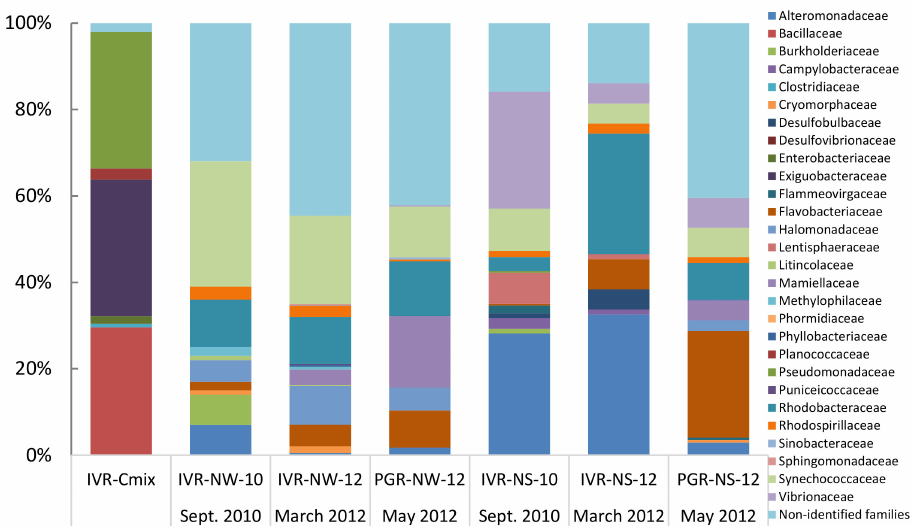
Figure 3. Relative composition (% total) of identified bacterial families represented by 16S rDNA sequences from cultures (IVR-CMix) and environmental samples collected at the Veracruz Reef System from different years (indicated by numbers), seasons and ecological compartments (N = Natural (non-cultured); W = Water column; S =